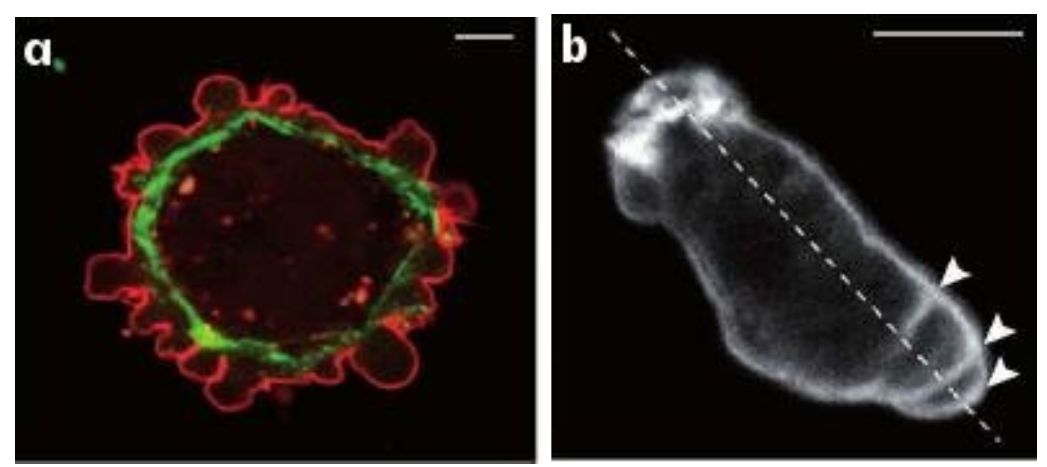
Figure 2. ( a ) Blebbing on a melanoma cell: myosin (green) localizes under the blebbing membrane (red) ( b ) The actin cortex of a Dicty cell migrating to the lower right. Arrowheads indicate the successive blebs and arcs of the actin cortex. The scale bar is 5 µ m is each panel. From